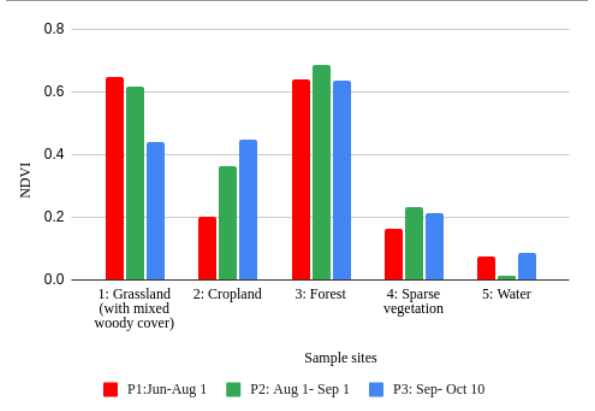
Figure 4: NDVI values for the different sample